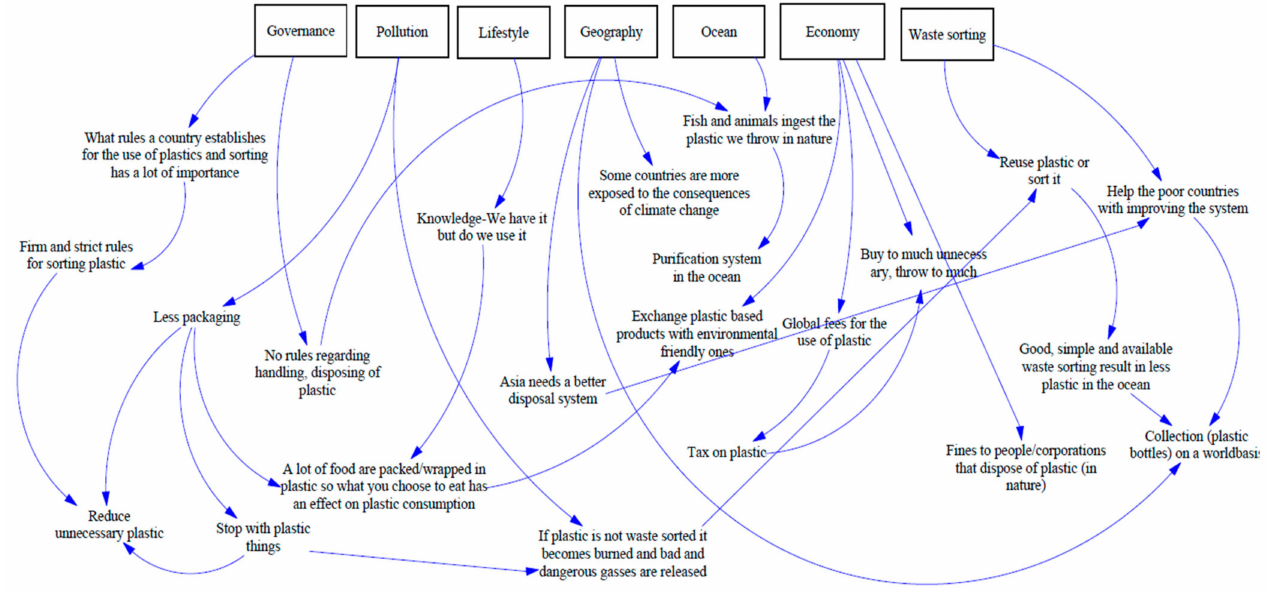
Figure 1. Vensim diagram of Norwegian youth